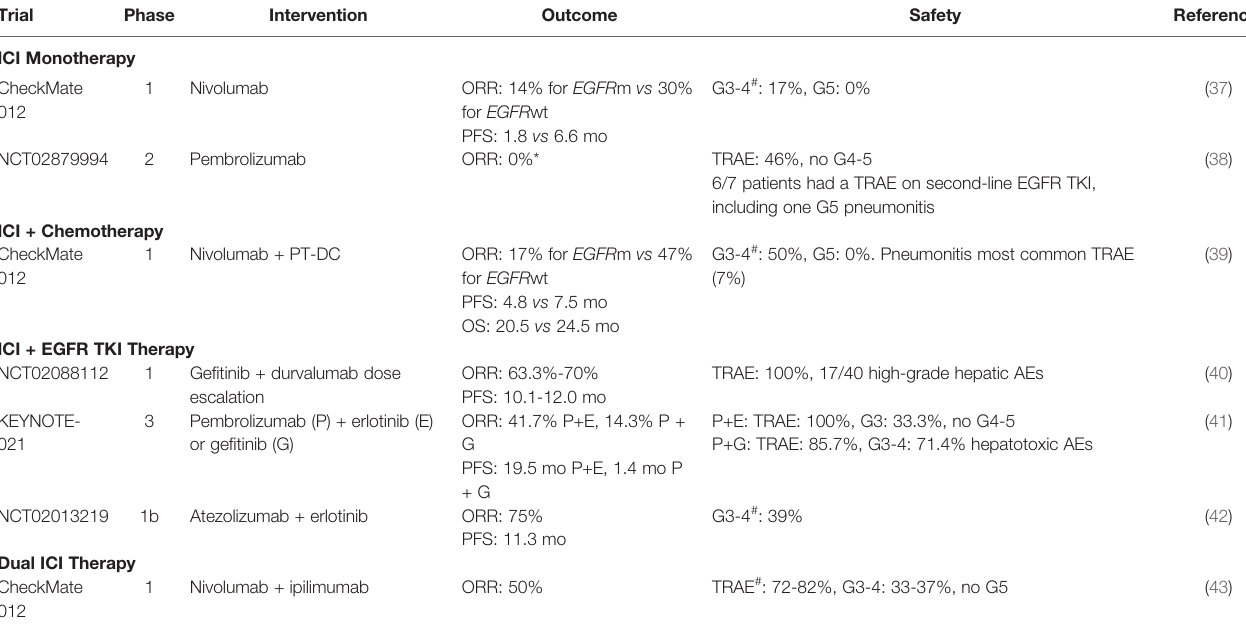
TABLE 1 | First-line ICI Clinical Trials in EGFR m NSCLC. Trial Phase Intervention